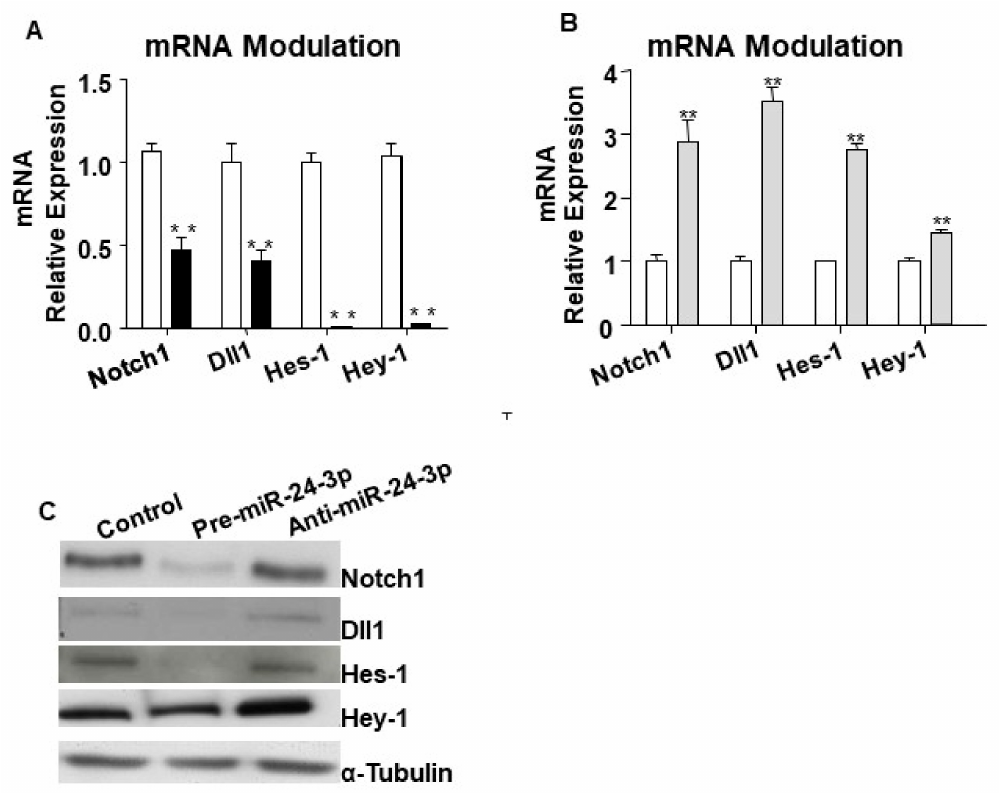
Figure 2. Notch1 and Dll1 direct targets of miR-24-3p and Notch pathway modulation in human umbilical vein endothelial cells (HUVECs). To validate the relation between miR-24-3p and the predicted targets Notch1 and Dll1, mRNA and proteins analyses were performed in HUVECs transfected with premiR-24-3p, anti-miR-24-3p, or control. Hes-1 and Hey-1 were also evaluated, as reporters of the Notch signalling activity. Bar graph ( A ) shows HUVEC transfected with pre-miR-24-3p (black columns) compared to control (scramble, white columns). Bar graph ( B ) shows HUVEC transfected with miR-24-3p inhibitor (light grey columns) compared to control (white columns). mRNA levels were normalised to 18S and quantified employing the 2 ∆∆ C t method and is presented as changes from the values in the respective control group. Experiments were performed in triplicate and repeated three times. Values are means ± SEM. T ** p < 0.01 vs. Notch1 3 (cid:48) -UTR + control. Panel ( C ) shows protein expressions of Notch1, Dll1, Hes-1, and Hey-1 forcing and inhibiting the expression of miR-24-3p. For Western blot analyses, α tubulin was used as house-keeping